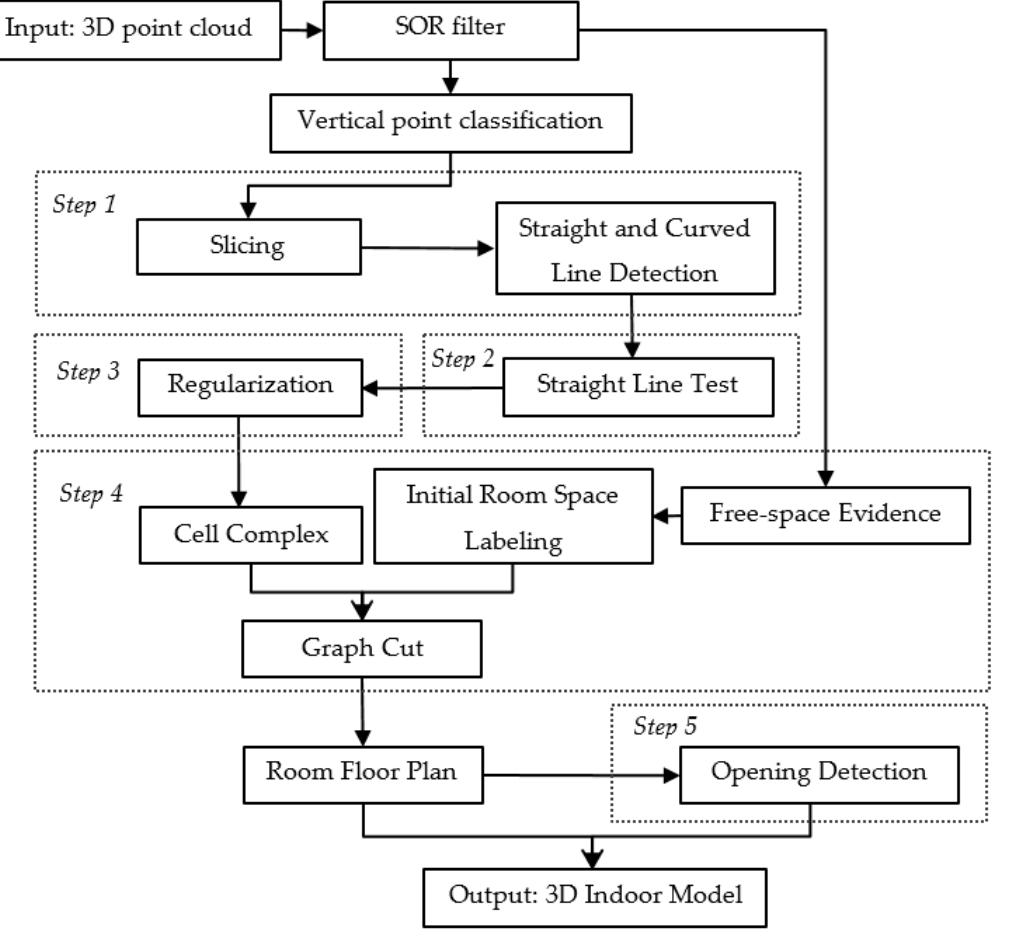
Figure 1. Working flowchart of the proposed method.